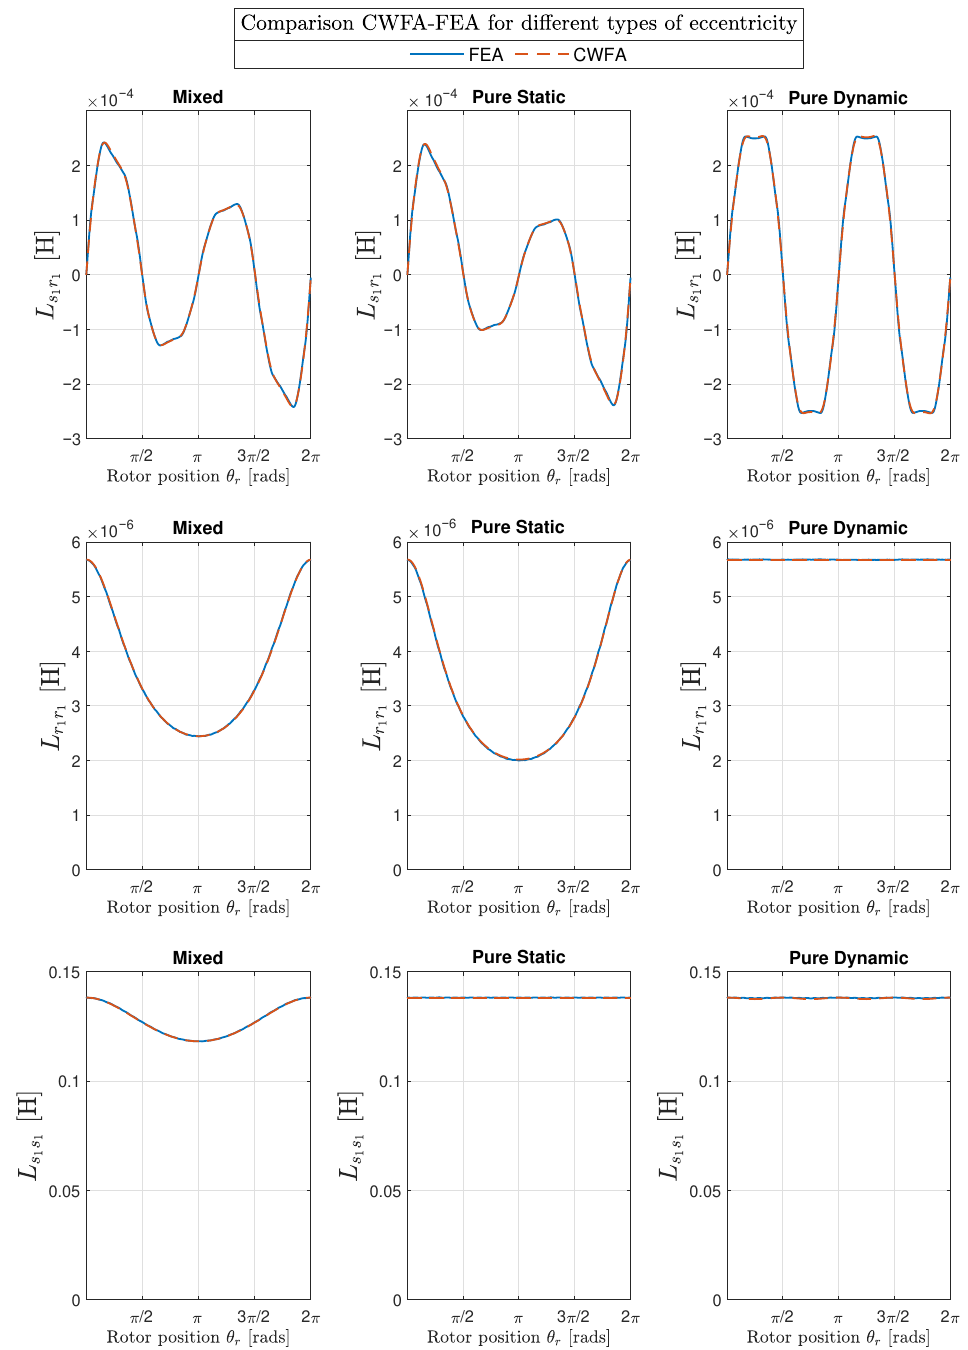
Figure 20. Mutual inductance between the first stator and the first rotor phase ( L s , top row ) and 1 r 1 self-inductances of the first rotor phase ( L r , middle row ) and of the first stator phase ( L s , bottom 1 r 1 1 s 1 row ), for the IM of Appendix A with three different types of eccentricity: mixed eccentricity ( δ s = 0.4, δ d = 0.2) in the first column, pure static eccentricity ( δ s = 0.6) in the second column, and pure dynamic eccentricity ( δ d = 0.6) in the third column. The results obtained with the conformal winding approach and with FEA have been plotted together for comparison